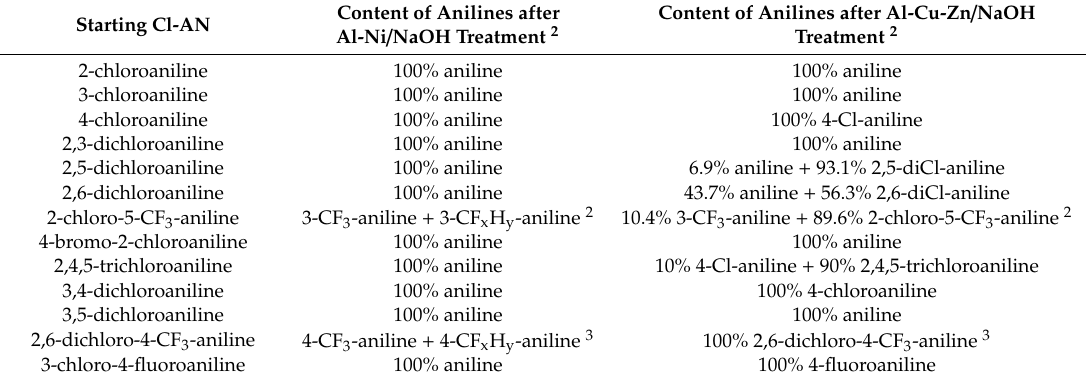
Table 1. Comparison of HDC reactivity of Raney Al-Ni and Devarda’s Al-Cu-Zn alloys toward di ff erent chloroanilines (Cl-ANs) 1